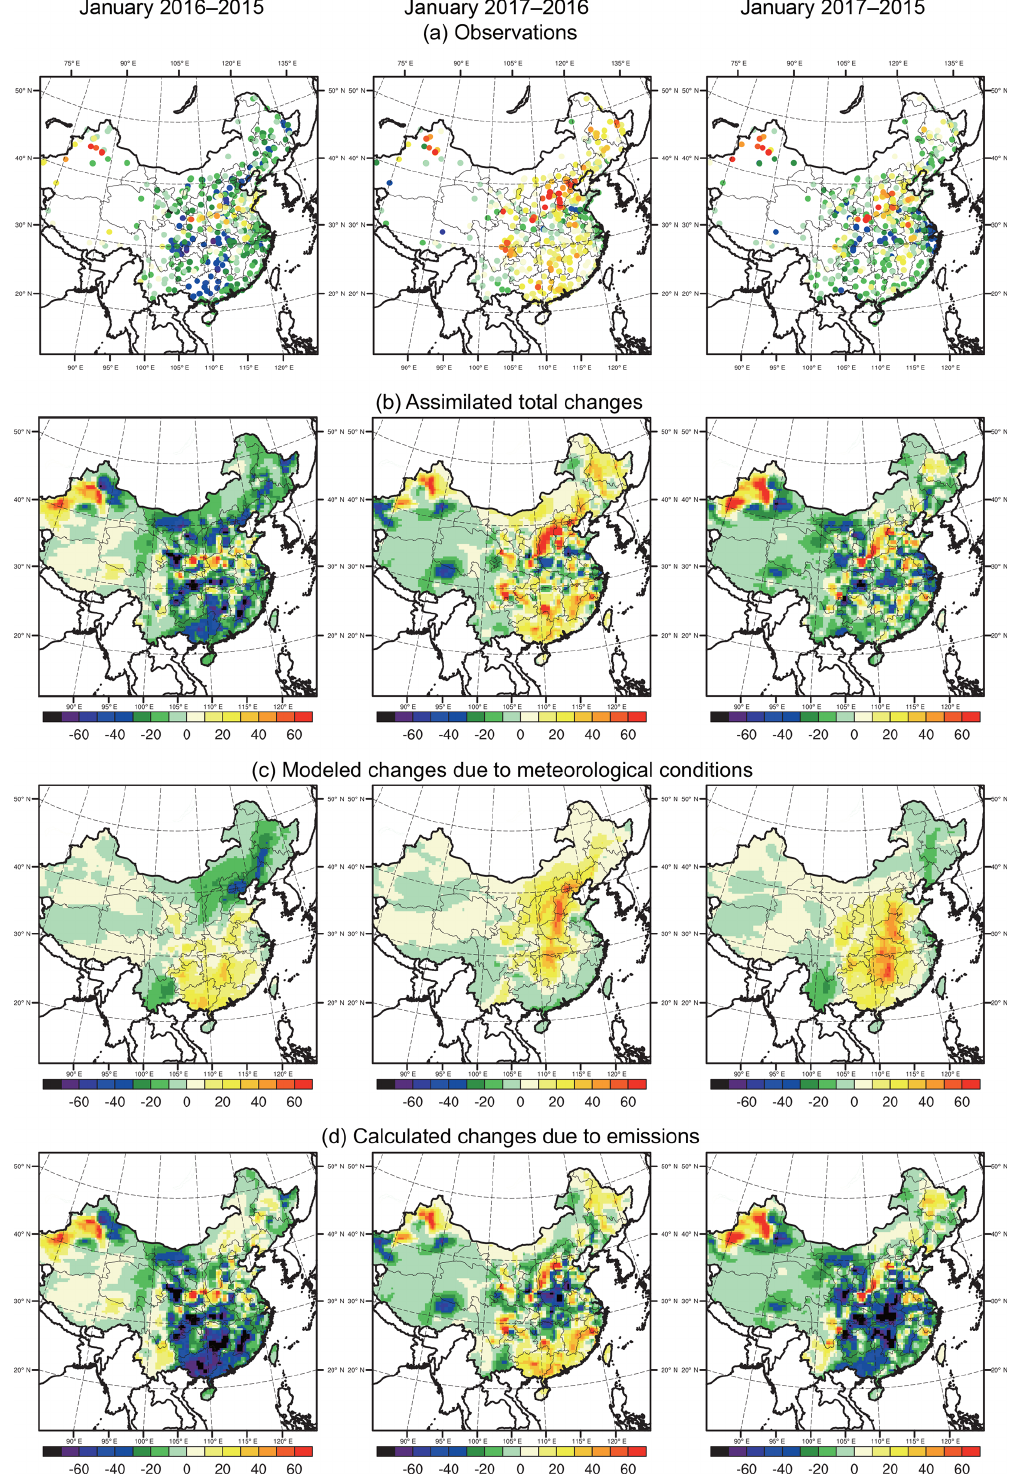
Figure 6. Observed and modeled ambient PM 2 . 5 concentration changes for January 2016–2015 (left), 2017–2016 (middle) and 2017– 2015 (right); (a) observations, (b) assimilated total changes, (c) modeled changes due to meteorological conditions and (d) calculated changes due to emissions (units: µgm − 3